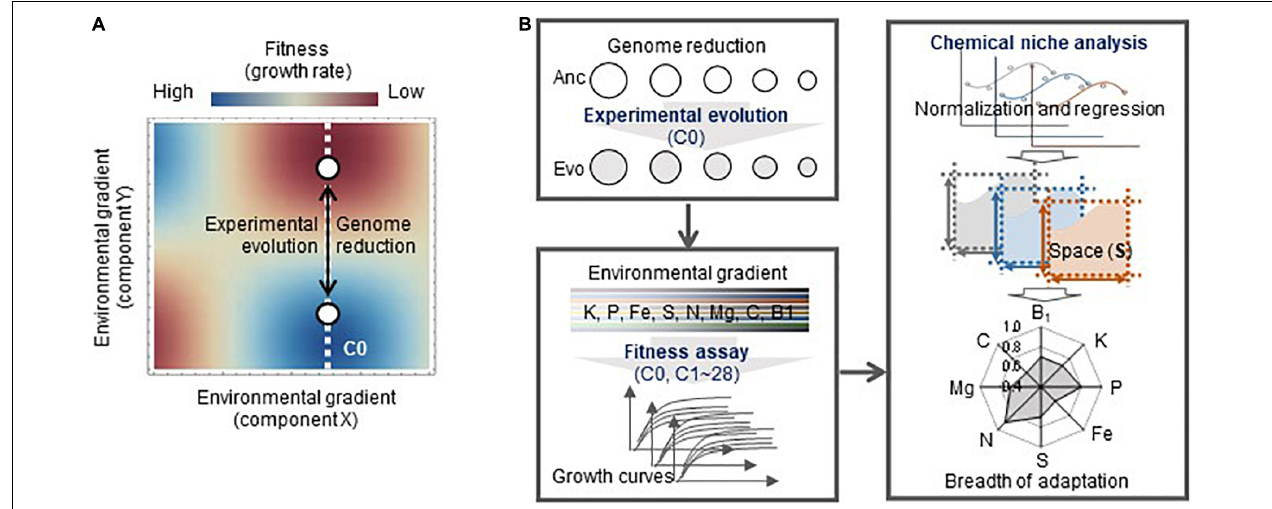
FIGURE 1 | Conceptual illustration of the study. (A) Fitness landscapes of the reduced genomes in the environmental gradient. The evolution of the genomes (open circles), from Anc to Evo, leads to not only adaptation to the environment for evolution (C0, white broken line) but also correlated adaptation to the environmental gradient. The color gradation from red to blue indicates the fitness from high to low. (B) Overview of the experiments and analyses performed in the present study. The experimental and analytical studies are categorized in three boxes, which are the experimental evolution, high-throughput fitness assay, and chemical niche analysis. Five genomes (strains) used for the evolution are shown as circles. The eight elements investigated in the chemical niche analysis are